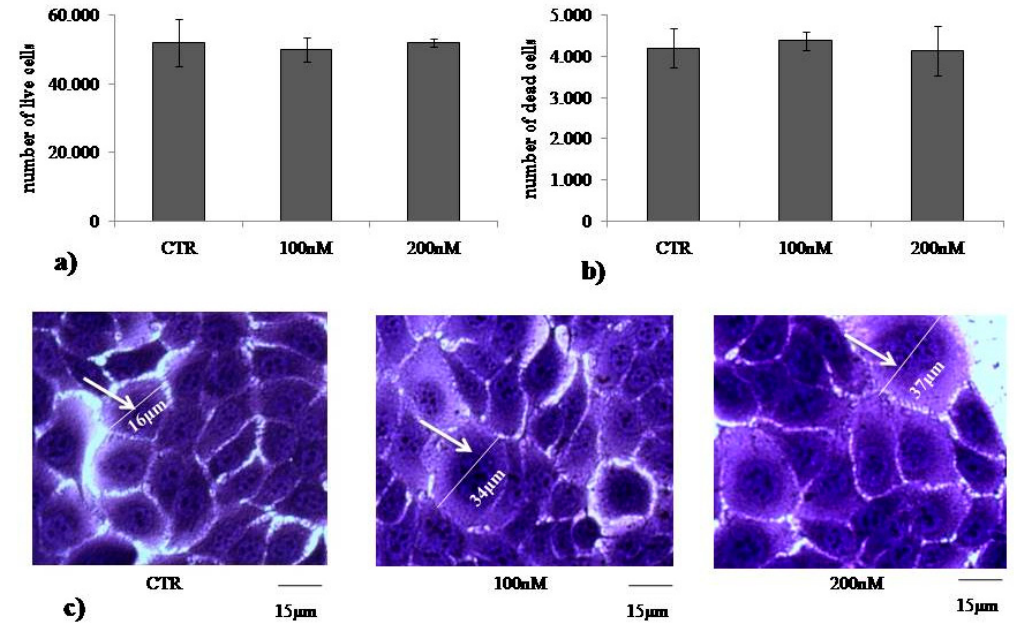
Figure 2. Effect of VD3 on HaCaT cell number and morphology. Cells were cultured in the presence of 100 and 200 nM VD3 for 24 h and then counted (( a ) live cells) or submitted to trypan blue exclusion assay (( b ) dead cells) or treated with stained solution of wound healing assay (( c ) cell morphology). For ( a ) and ( b ), data are expressed as mean ± SD of three independent experiments performed in duplicate. Significance, * p < 0.001 versus control sample.